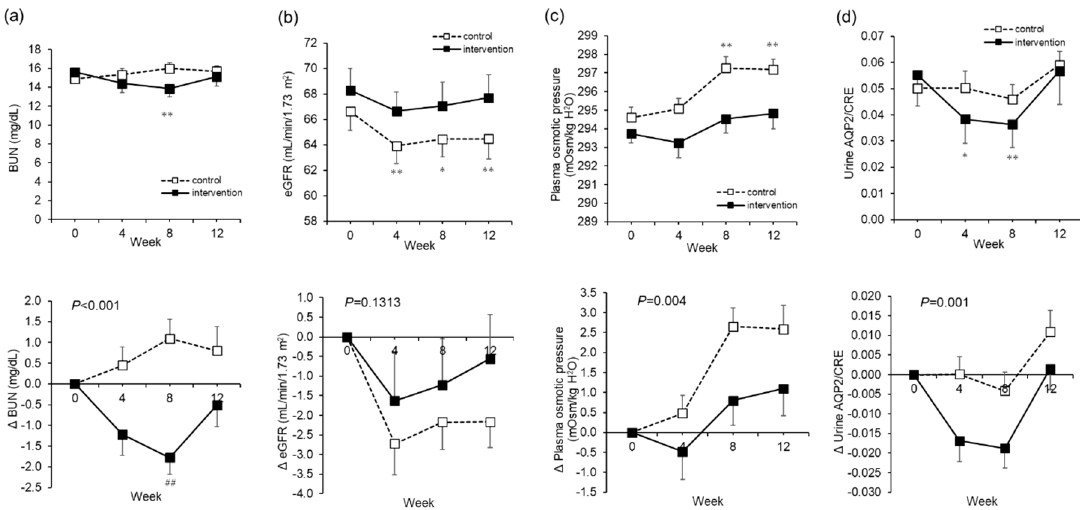
Figure 6. Renal functions, plasma osmotic pressure, and urine aquaporin2 / creatinine (AQP2 / CRE). The actual level (upper) and changes (lower) in blood urea nitrogen (BUN) ( a ). The actual level (upper) and changes (lower) in the estimated glomerular filtration rate (eGFR) ( b ). The actual level (upper) and changes (lower) in plasma osmotic pressure ( c ). The actual level (upper) and changes (lower) in urine AQP2 / CRE ( d ). The dotted line is the control group. The solid line is the intervention group. Mean ± SEM. The P value is the di ff erence between the groups for the change from Week 0 to Week 12. Two-way analysis of variance was performed. * Paired t -test adjusted by the Bonferroni method was performed for intragroup comparisons from Week 0. * p < 0.05, ** p < 0.001, ## p <